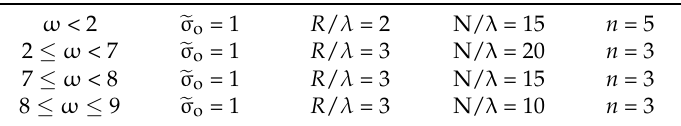
Table 1. Optimum PML